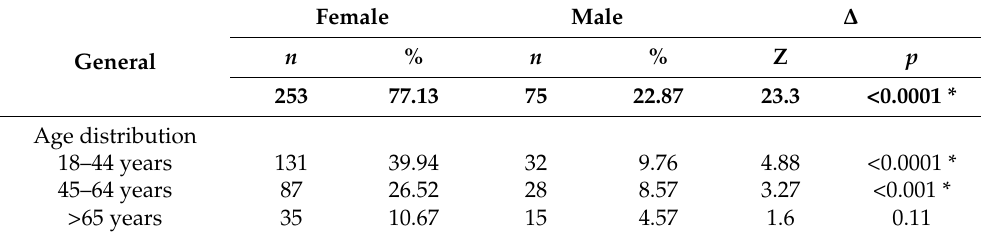
Table 1. Proportion differences between